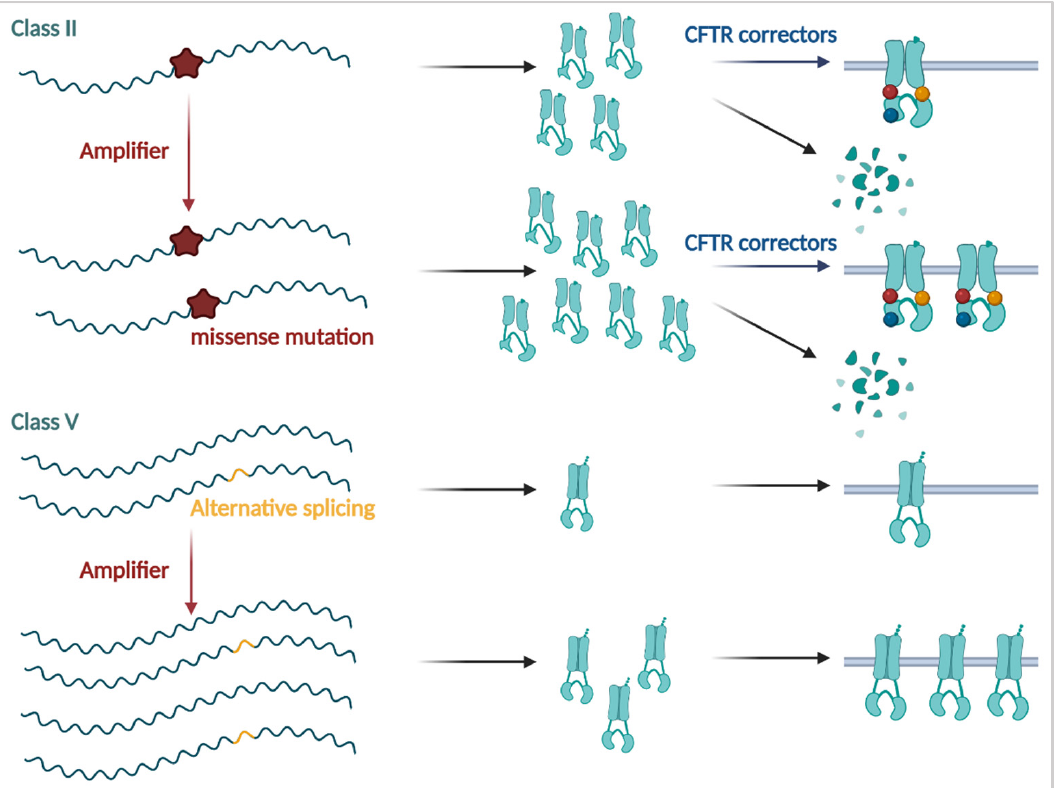
Figure 6. Amplifiers stabilize the CFTR mRNA and thereby increase translation, enlarging the pool of immature CFTR protein. Amplifiers (red) are of particular interest for the treatment of Class II and V mutations. Top: Class II mutations are misfolded and only a fraction reaches the plasma membrane, even in the presence of CFTR correctors (blue). Amplifiers provide more immature protein that can subsequently be rescued with CFTR modulators. Bottom: Class V mutations introduce cryptic splice sites, resulting in a mix of normal and alternatively spliced (yellow) CFTR mRNA. The fraction of normal mRNA gives rise to wild-type CFTR, but the number of channels is severely reduced. Enhancing the number of correct mRNA transcripts results in more CFTR protein at the